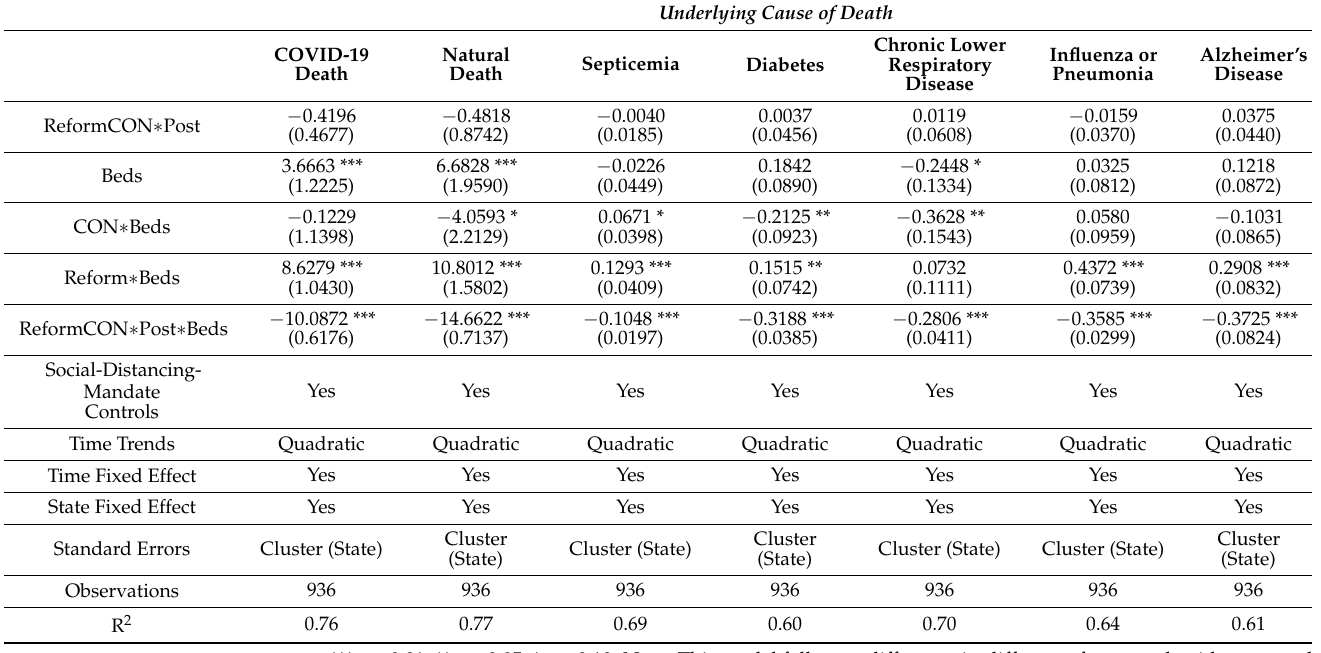
Underlying Cause of Death